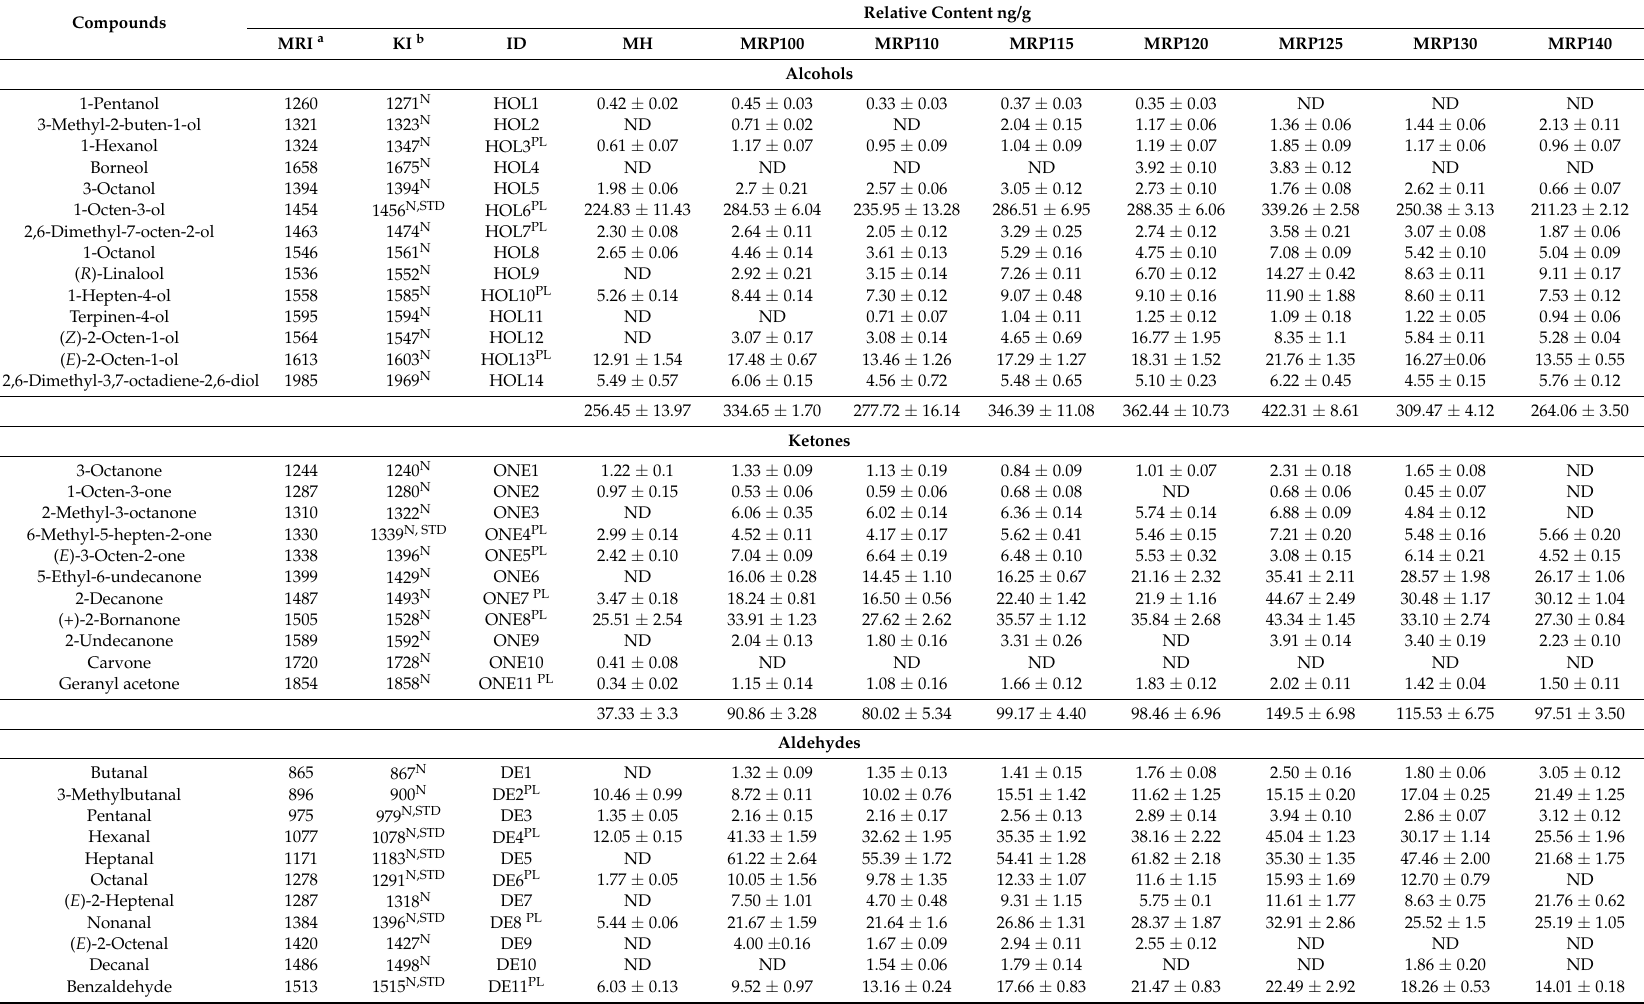
Table 1. Volatile compounds detected in MH and